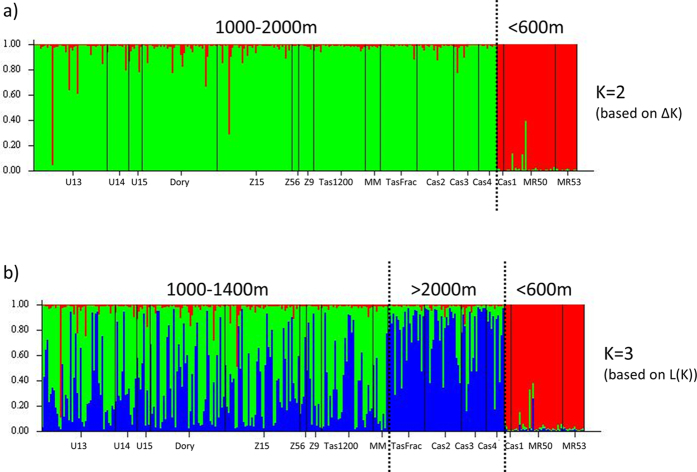
Genetic groups within Desmophyllum dianthus, based on output from STRUCTURE analysis and grouped by collection depth.